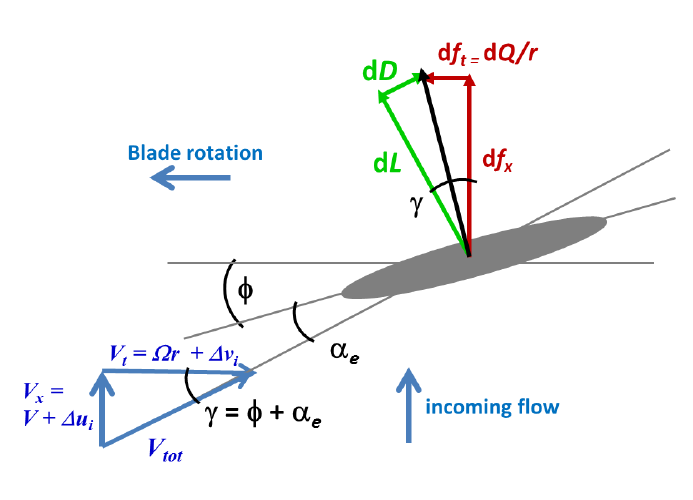
Figure 3. Inflow velocity components and hydrodynamic force components on turbine blade section at radius r .